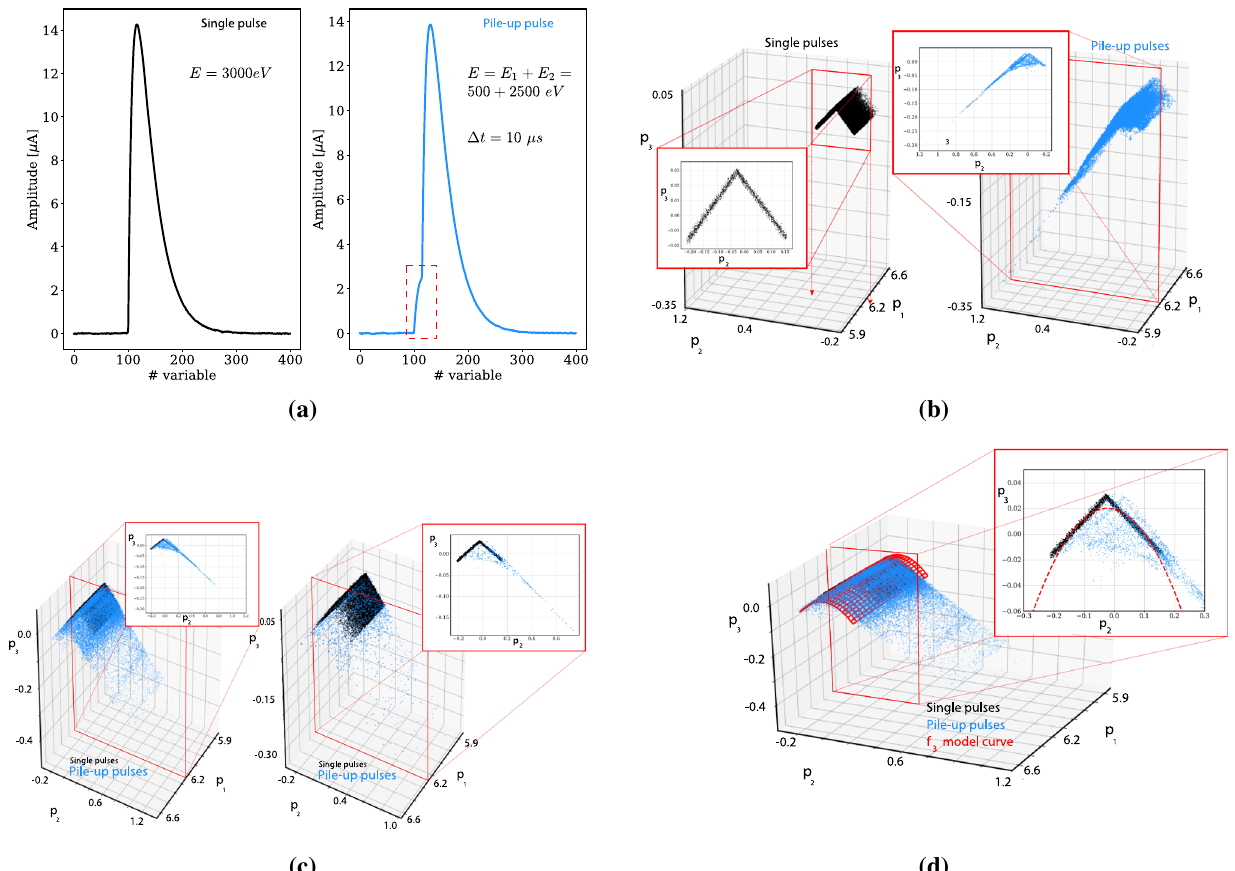
Fig. 2 a Each event (row) of the matrix M is initially described by 400 variables, i.e., samples; we can represent each event as shown in figure or as points in R 400 . M contains two different types of events: single pulses ( A ) of energy E and pile-up pulses with different arrival time ( B ) with energies E 1 and E 2 such that E 1 + E 2 = E . b The events of M are represented in the projections space. In this space, the two types